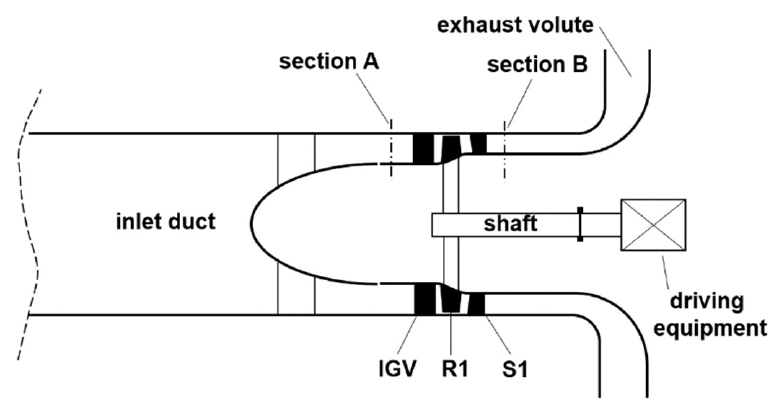
Figure 1. Sketch of the test rig.